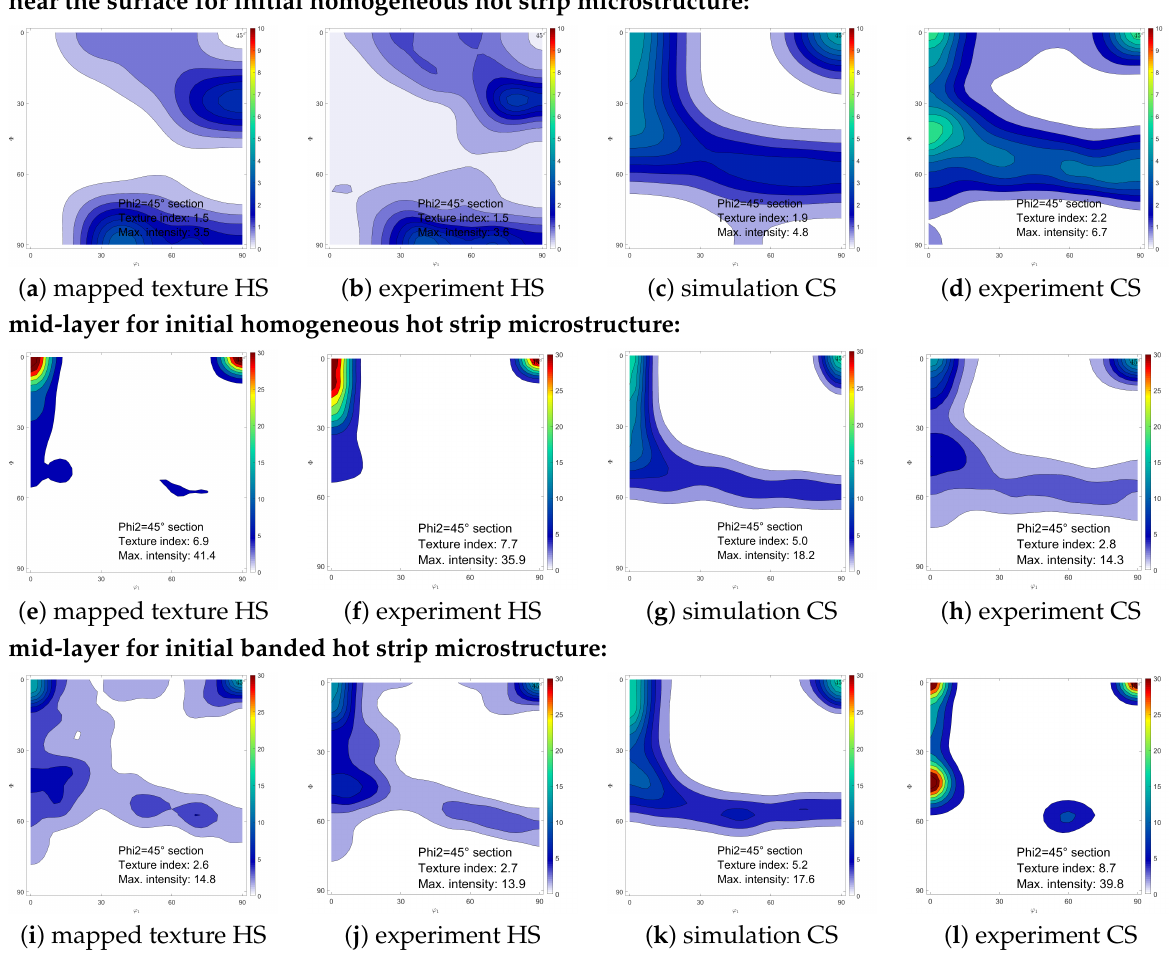
Figure 7. Comparison of experimental and simulation results for the texture evolution in Fe3.2wt.%Si steel. ( a – d ) Measured and predicted texture evolution near the surface of a homogeneous hot strip microstructure, ( e – h ) Measured and predicted texture evolution in the mid-layer of a homogeneous hot strip microstructure, ( i – l ) Measured and predicted texture evolution in the mid-layer of hot strip with a banded microstructure. HS—hot strip, CS—cold